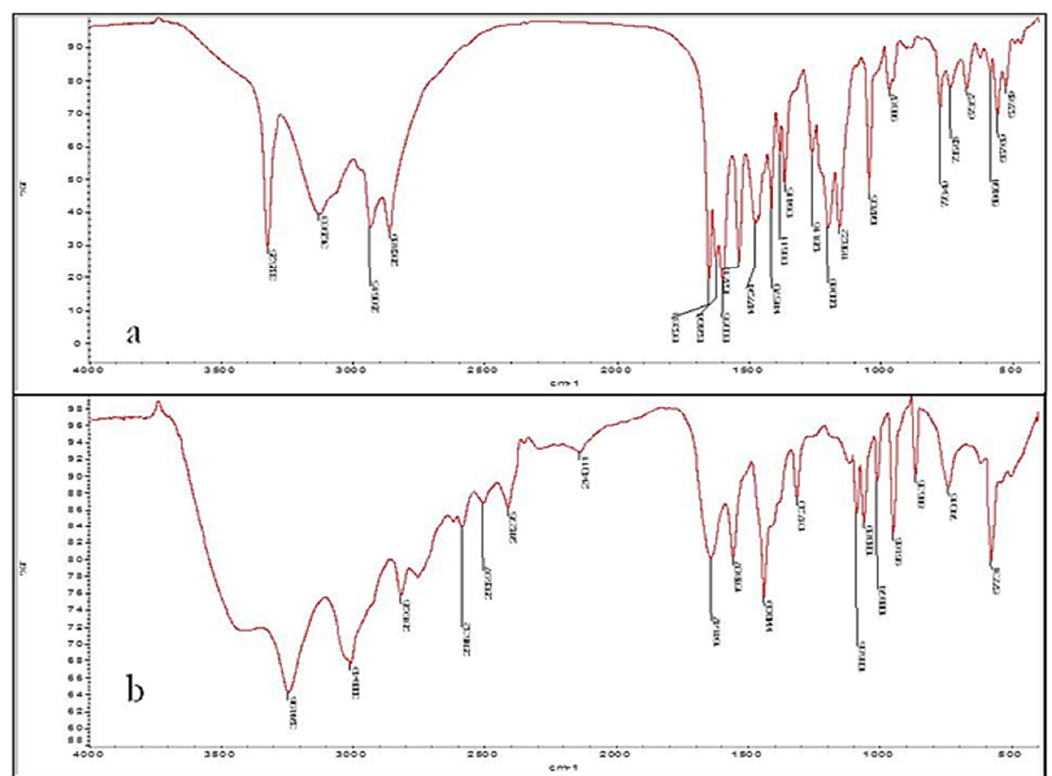
Figure 5. FTIR spectra of standard desferal (a) and siderophore extracted from Pseudomonas sp.